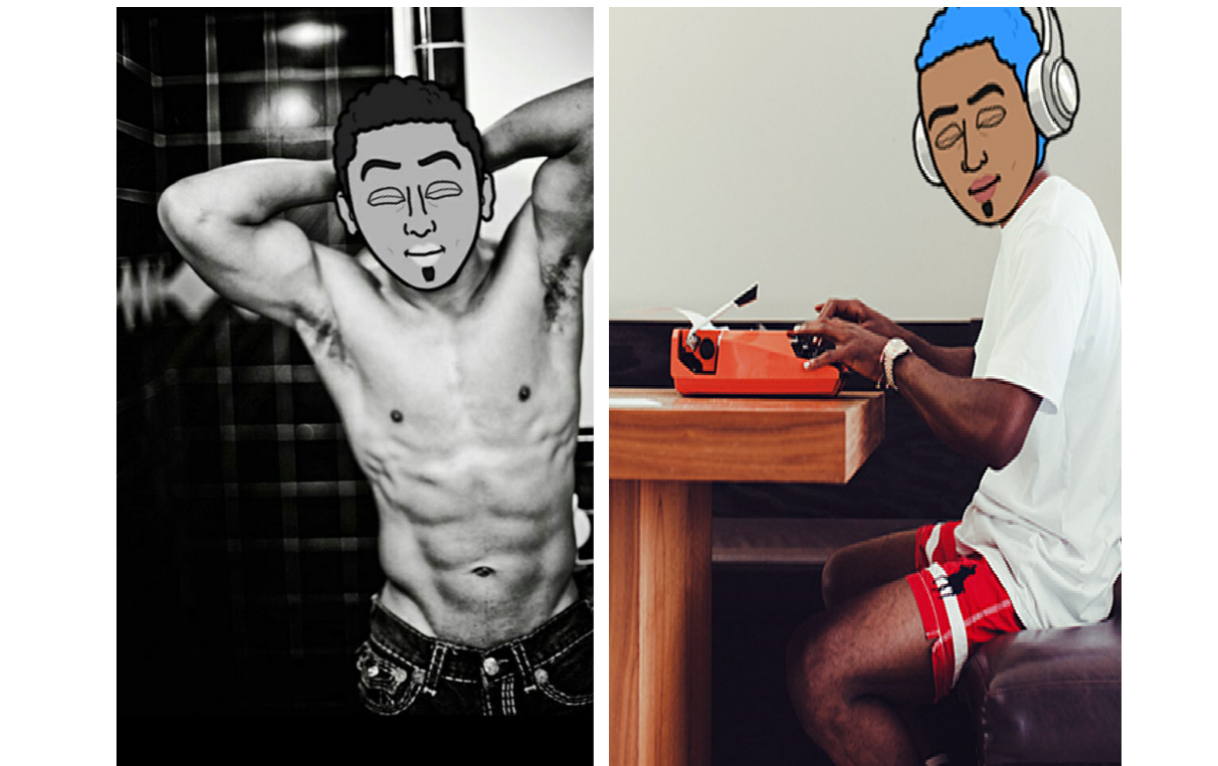
Figure 1. Sample profile